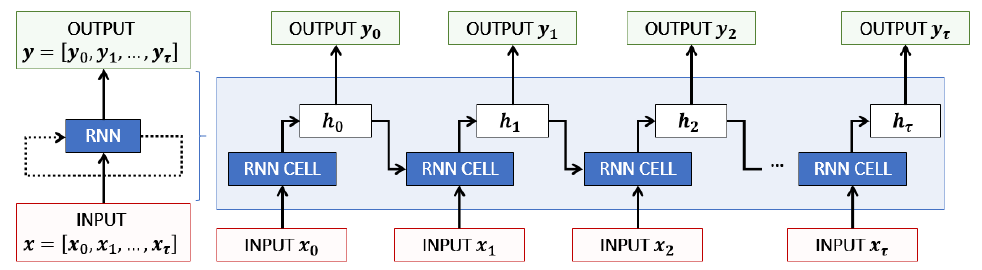
Figure 1. RNN layer overview, roll and unroll: many-to-many representation. Vanilla RNN, the simplest RNN structure, suffers from gradient vanishing and explo- sion during the training step [33,34]. In the gradient vanishing case, backpropagation